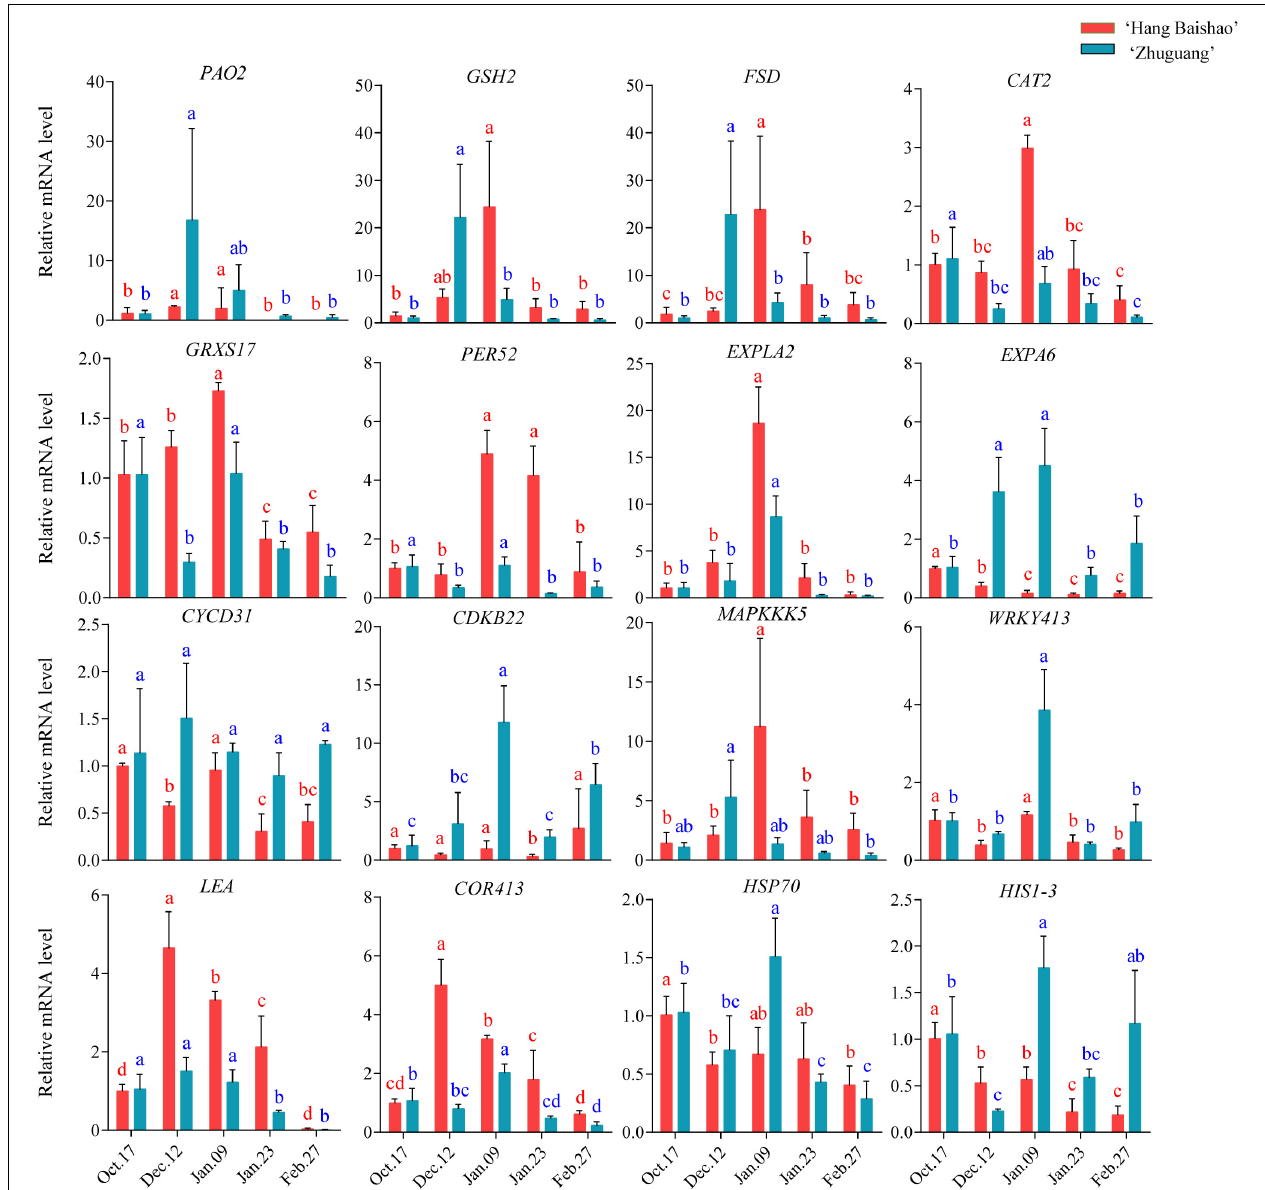
FIGURE 7 | Effect of natural chilling on oxidative stress related genes expression in ‘Hang Baishao’ and ‘Zhuguang’ during bud dormancy. Error bars represent standard deviation from three biological replicates and different letters indicate significant differences ( P < 0.05). Differences were compared among different move dates for each